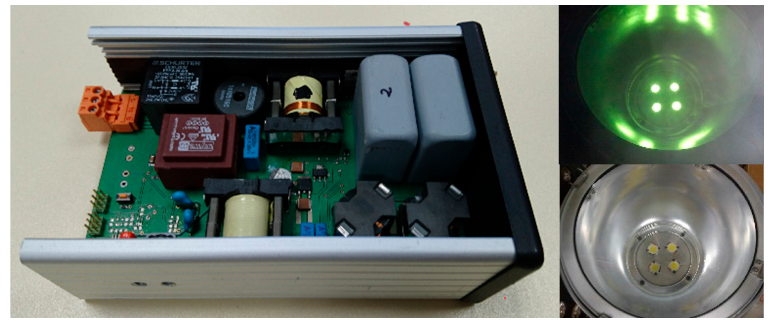
Figure 12. Experimental prototype and lamp composed of four LED arrays BXRA-C2000. Case size is 16 cm × 10 cm × 5 cm.